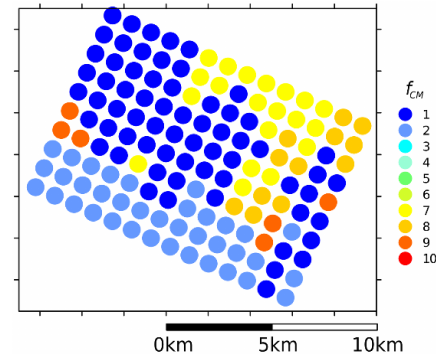
Figure 4. Test case 2: one realization out of the 2-D f CM field ensemble. The compressibility varies in the area corresponding to the enlargement of Fig.